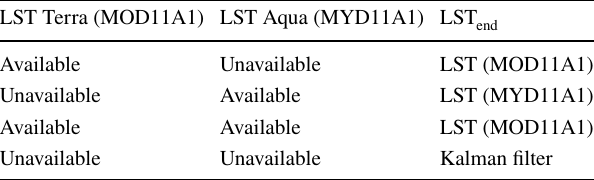
Table 3 Combining LST Aqua and